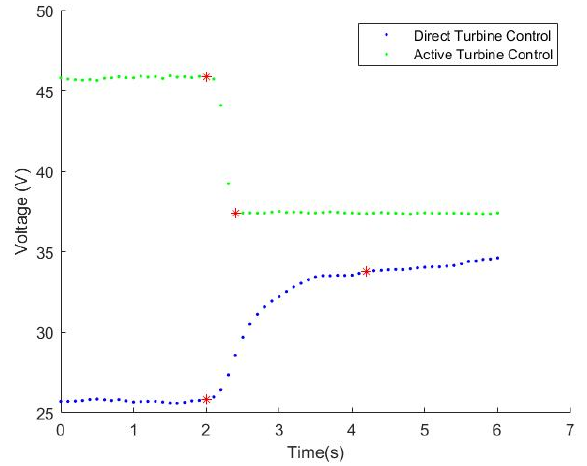
Figure 13. A comparison of voltage supplied by ATC and DTC arrangements was taken from the 50–100% tests.